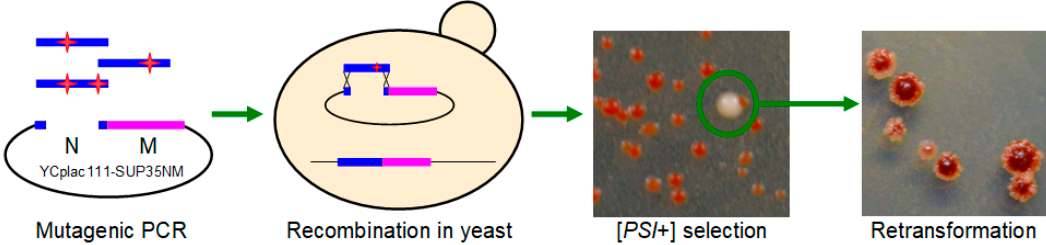
Figure 1. Isolation of Sup35N mutants able to cause [ PSI + ] appearance without overproduction.